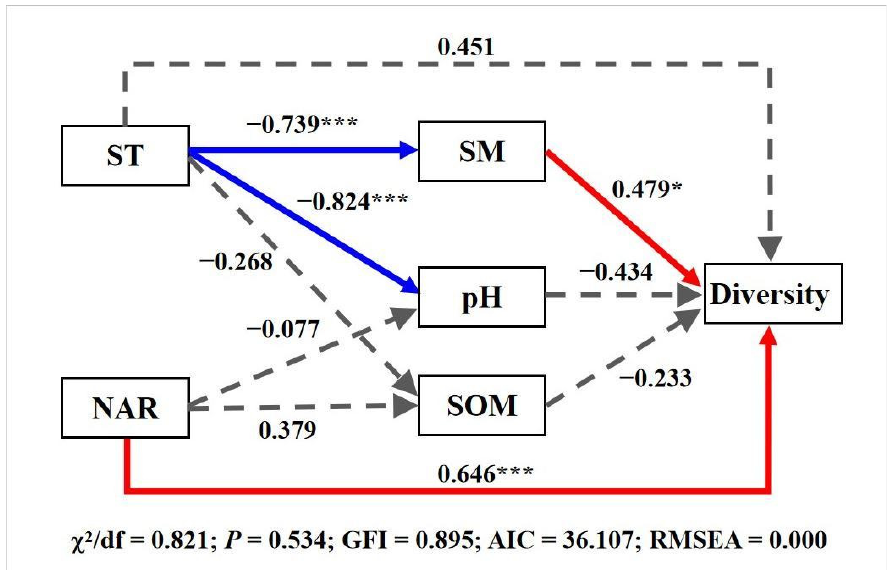
Figure 5. Structural equation models of the soil temperature, nitrogen application rate, and soil properties as predictors of soil bacterial diversity. Solid red arrows represent positive paths ( p < 0.05), solid blue arrows represent negative paths ( p < 0.05), and dotted grey arrows represent nonsignificant paths ( p > 0.05). The estimated value of the path coefficient represents the size of the impact scale. * p < 0.05; *** p < 0.001; ST: soil temperature; NAR: nitrogen application rate; SM: soil moisture; pH: soil acidity; SOM: soil organic matter.